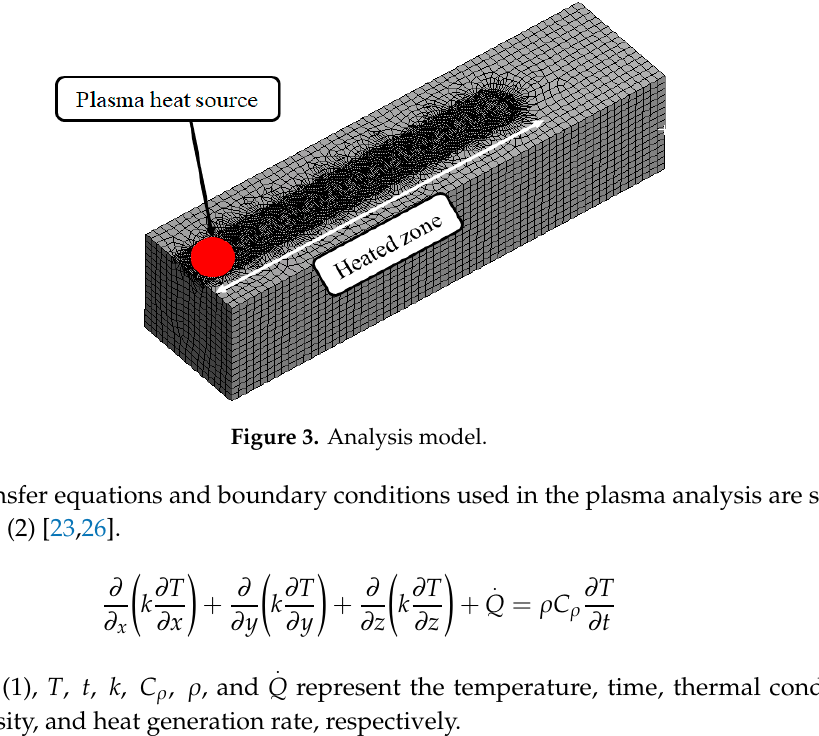
Table 1. Chemical composition of Ti-6Al-4V (wt.%).